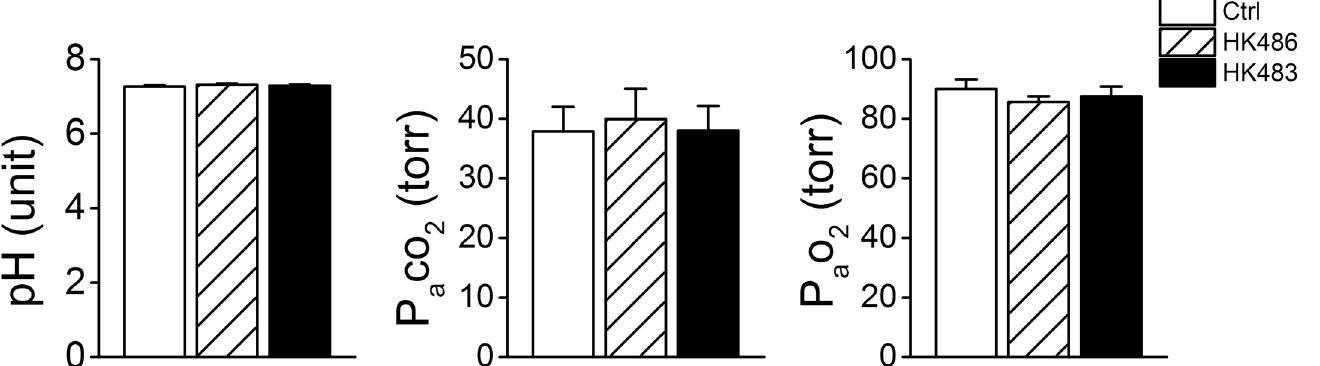
Fig 7. Effects of viral infection on pH and blood gases. Arterial blood was sampled at 3 dpi in anesthetized Ctrl, HK486 and HK483 mice (n = 7/each group). Mean ± SE. There is no difference in blood gases/pH among the three groups at 3 dpi.